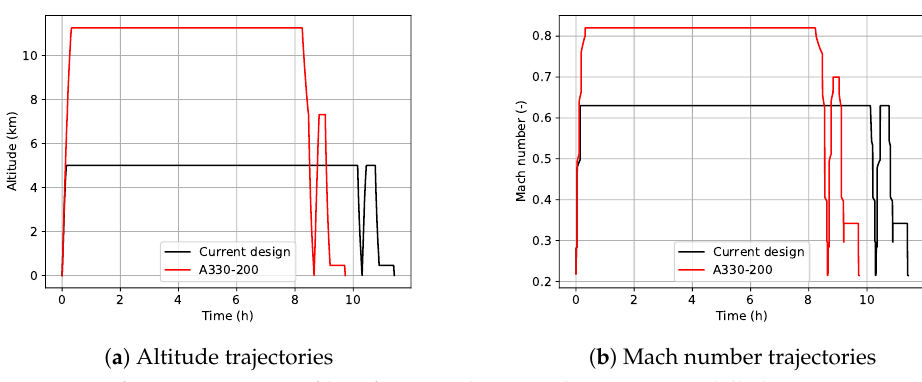
Figure 5. Reference mission profiles of current design and A330-200 modelled in SUAVE.